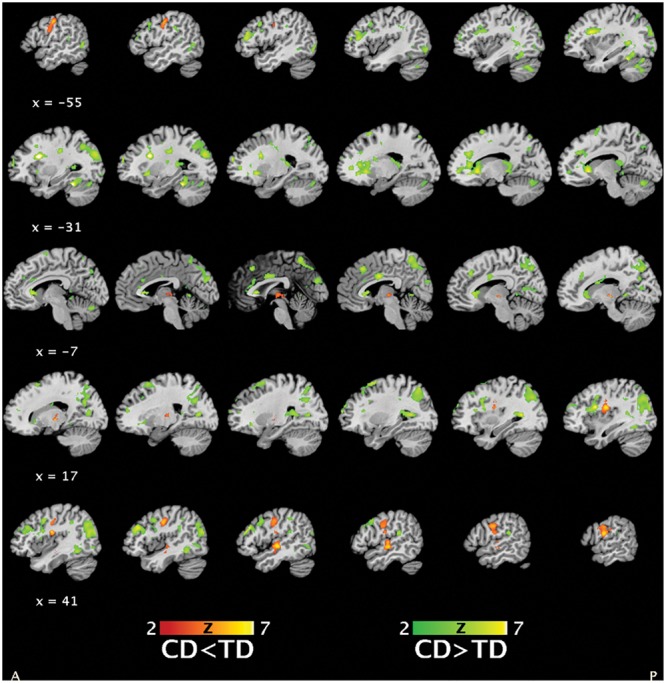
Statistical parametric maps depicting the main effect of group (masked post hoc t-tests for group differences in brain activation between conduct disorder (CD) and typically developing (TD) adolescents, 39CD/39TD; hypoactivations in CD in red-yellow, hyperactivations in CD in green-yellow) (p < 0.05, FWE).